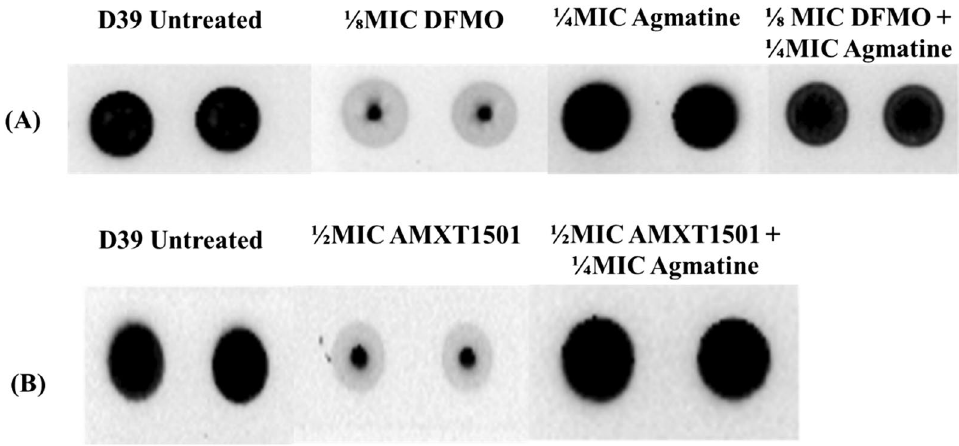
Figure 8. Agmatine reverses the capsule inhibitory effect of ( A ) DFMO, and ( B ) AMXT 1501 in Serotype 2 (D39) pneumococci. Total CPSs isolated from serotype 2 (D39) cultured in THY (untreated), THY supplemented with DFMO (1/8 MIC, 34 mM) alone, agmatine (1/4 MIC, 20 mM) alone, DFMO (1/8 MIC) with agmatine (1/4 MIC), AMXT 1501 (1/2 MIC, 7.4 µM) alone, AMXT 1501 (1/2 MIC, 7.4 µM) and agmatine (1/4 MIC, 20 mM) were spotted on a nitrocellulose membrane. Probing with anti-serotype 2 specific antibody and a horseradish peroxidase (HRP)-conjugated secondary antibody, the membrane was developed with enhanced chemiluminescence (ECL) detection and scanned using a ChemiDoc XRS+ with Image Lab software (Bio-Rad, Hercules, CA, USA). Untreated pneumococcal D39 is shown to be encapsulated. DFMO treatment inhibits the capsule production while agmatine alone does not impact the capsule. Concomitant addition of agmatine in DFMO treated cells restored capsule in D39. Loss of capsule by AMXT 1501 was also fully restored by excess agmatine.